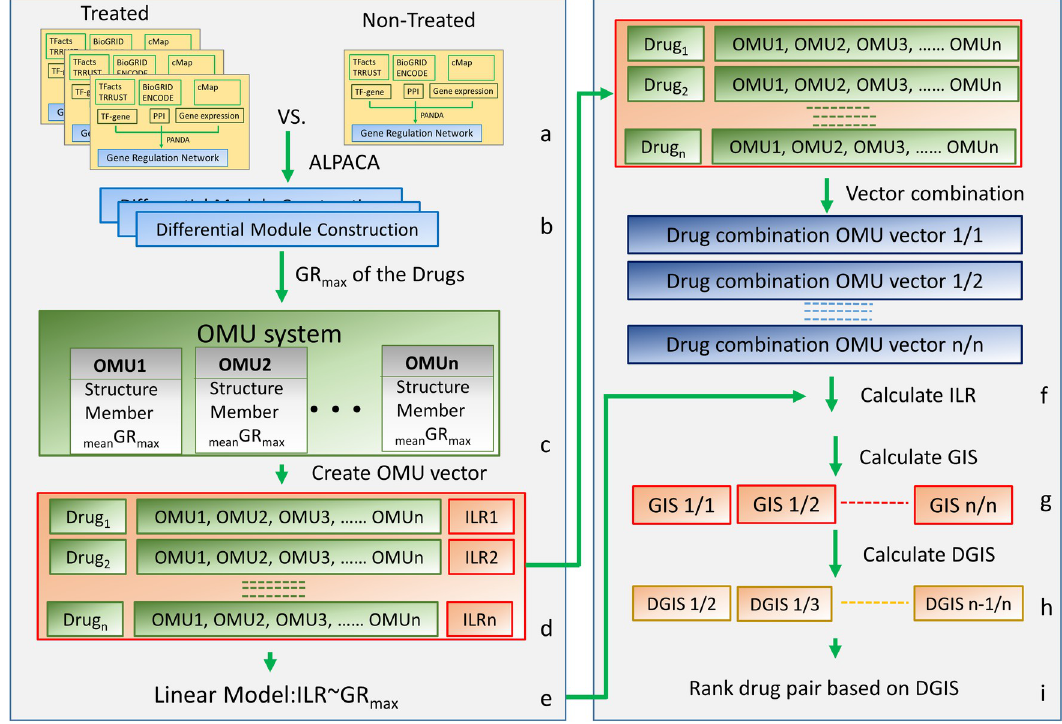
Fig 1. Schematic of the algorithm pipeline. (a) Re-construction of GRNs. (b) Generation of differential network. (c) Create an OMU system. (d) Create the drug OMU vector. (e) Linear model (f) Calculate the ILR for combined OMU vector. (g) GIS calculation (h) DGIS calculation (i) Sorting based on